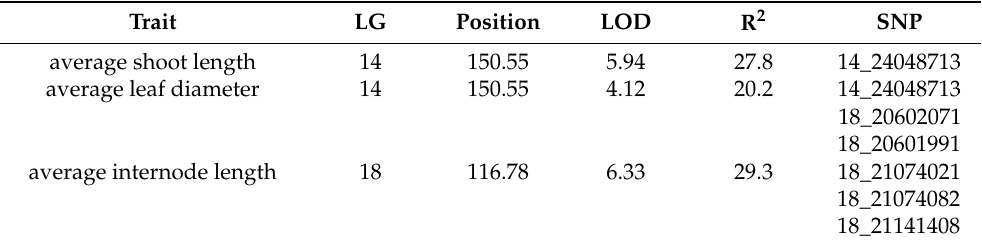
Table 4. Quantitative trait loci (QTL) mapped for morphological traits assessed for seedlings of cv. Dixie S1 population. Trait LG Position LOD R 2 SNP average shoot length 14